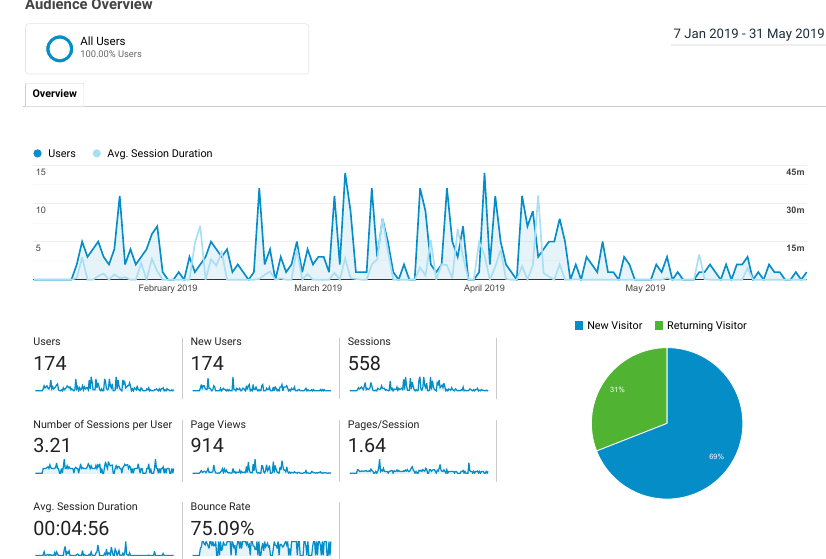
Figure 6. Usage analytics of the CloudTrail-Tracker